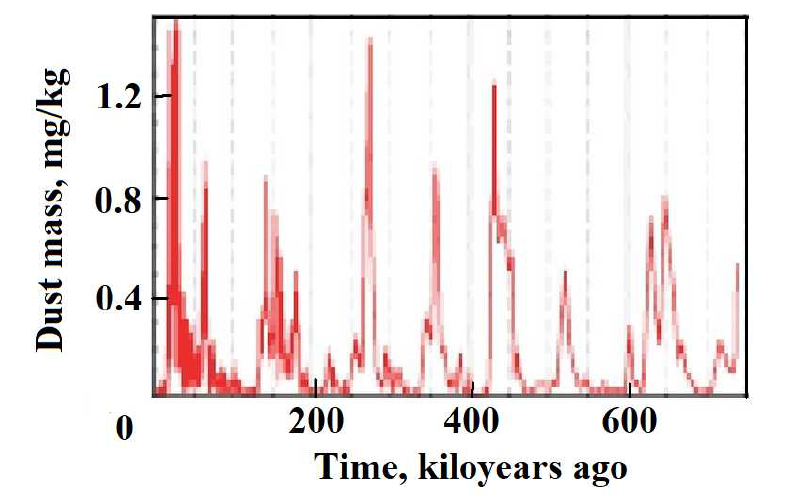
Figure 8. The relative mass of dust in ice deposits near the weather station Dome C [8]. The value of mg/kg means the mass of dust of 1 mg per 1 kg of